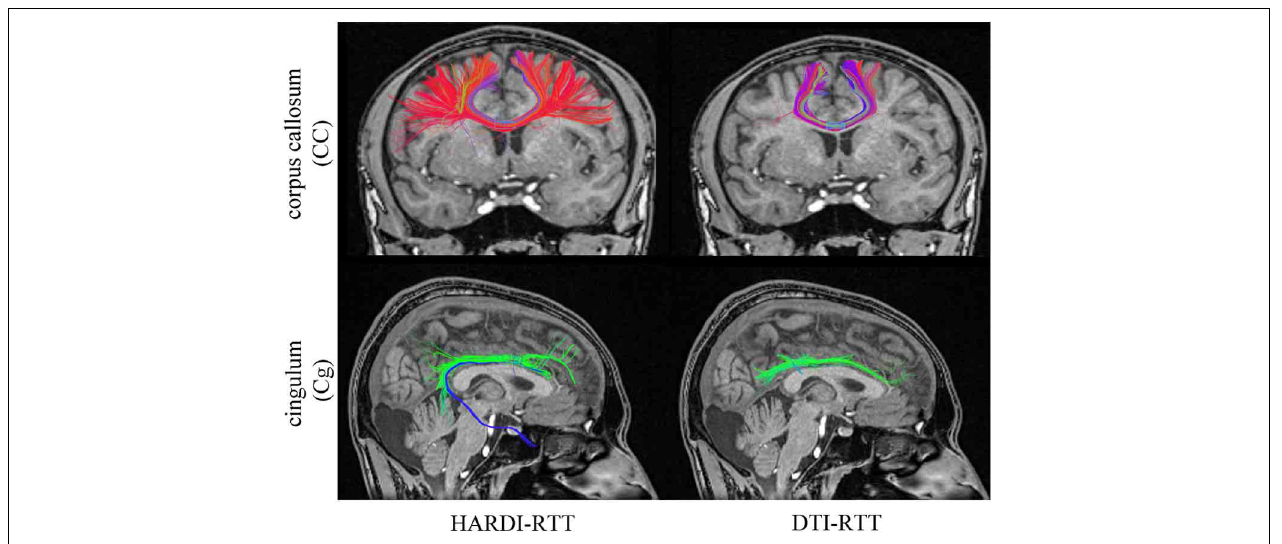
FIGURE 4 | Streamlines obtained with HARDI (left column) and DTI (right column) tractography. HARDI reconstructions reveals lateral fibers which are not present in the DTI reconstruction.